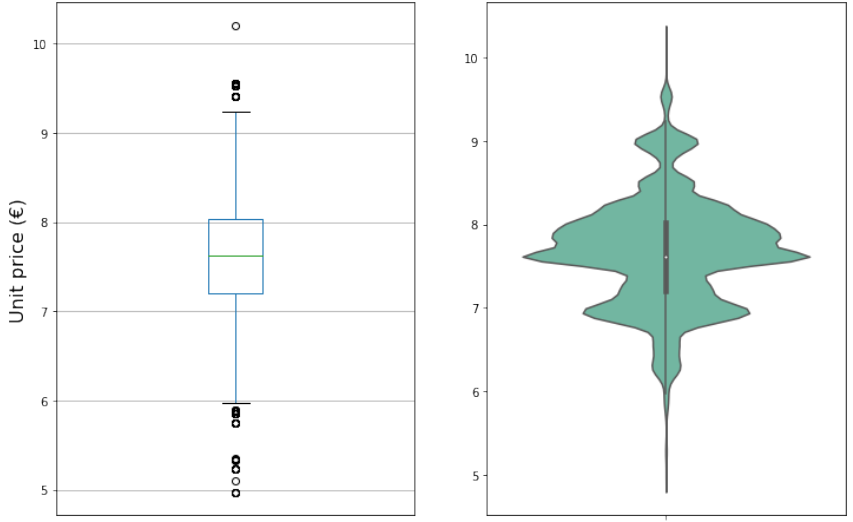
Figure 1. Price distribution (after z-score filtering) for product 2: to the left, boxplot, and to the right, violin plot.